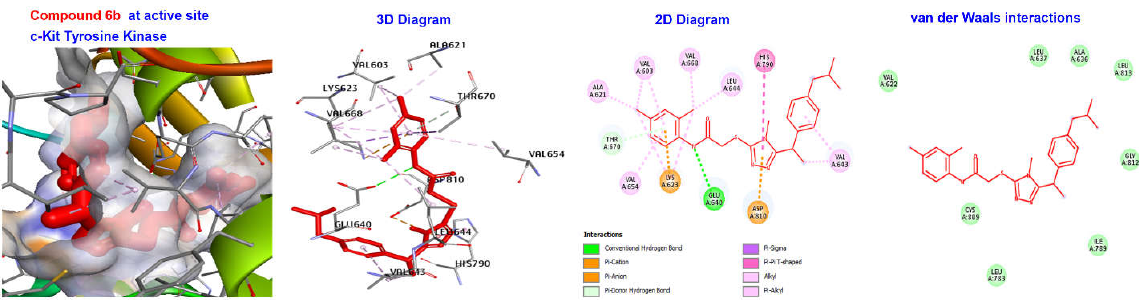
Figure 8. Binding pocket of docked ligand 6b in active site of c-Kit Tyrosine Kinase B.